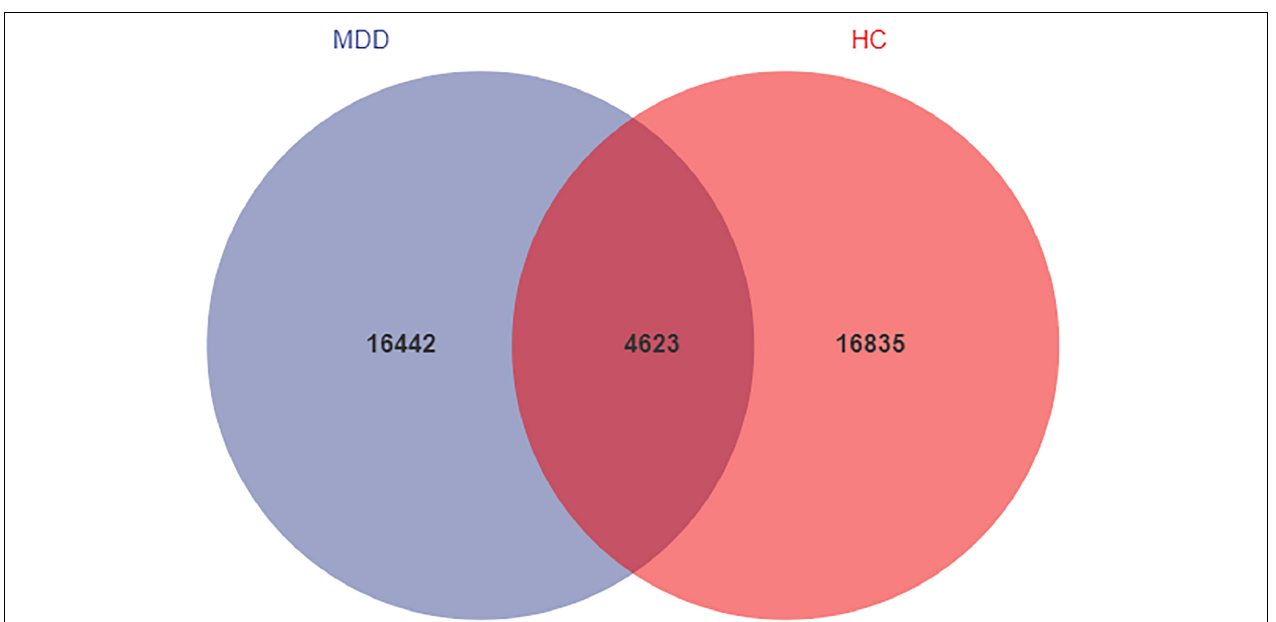
FIGURE 1 | Venn diagram of ASV in MDD and HCs. The blue and red colors represent MDD group and HC group, respectively. The overlapping area between the color blocks indicates the common ASV between two groups, and the number of each block indicates the number of ASV.